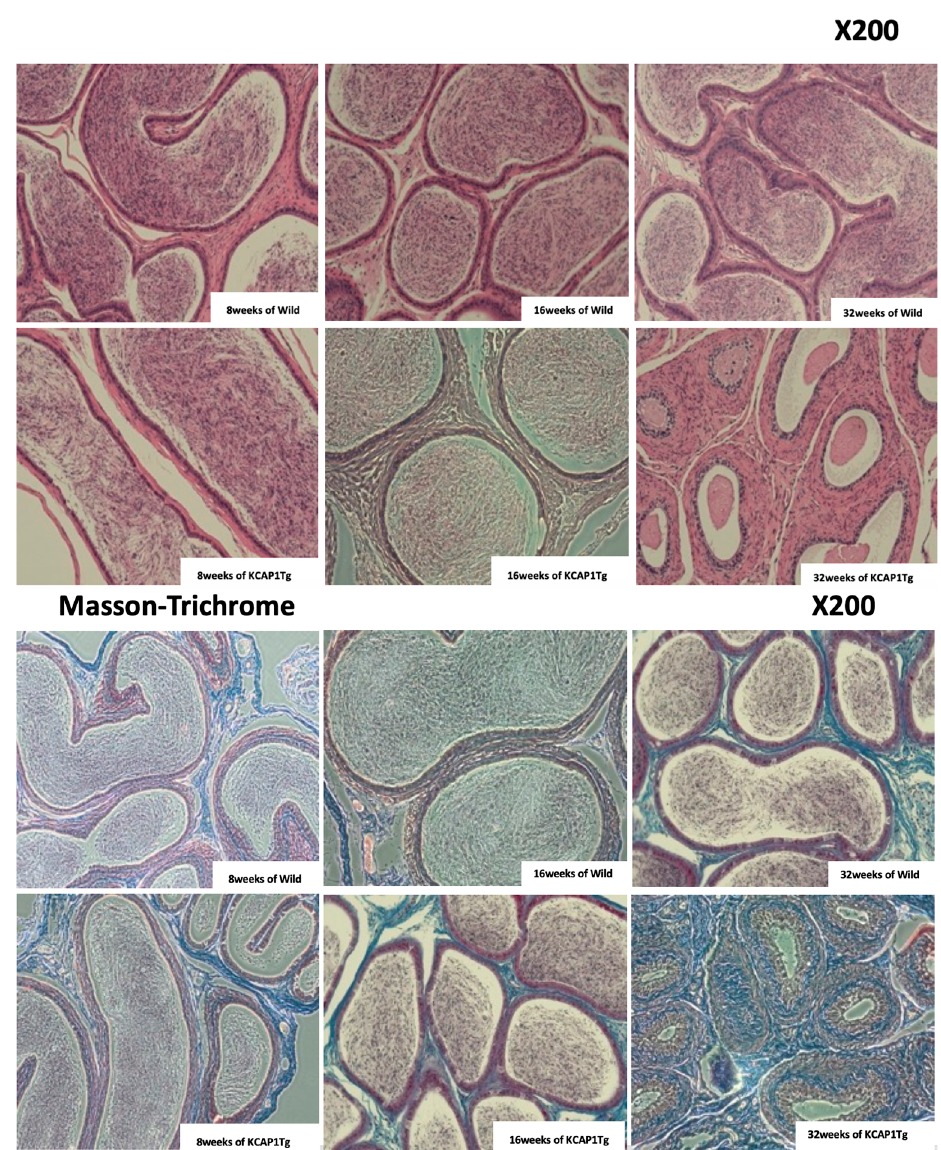
Figure 6. Histological findings for 8, 16, and 32 weeks of age of testis and epididymis in KCASP1Tg and wild-type mice. Histological changes of testis ( A ) and epididymis ( B ) in KCASP1Tg and wild-type mice at 8, 16, and 32 weeks of age were shown ( × 200, × 400). Comparison of the seminiferous tubules cross-sections, KCASP1Tg mice at 32 weeks old showed reduced sperm content in the lumen (L) of seminiferous tubules ( × 200). Large round cells with abnormal mitosis (circled) and sperm head (arrow) were seen in the lumen in KCASP1Tg mice, but not in the wild type. Leydig cells (LC) in KCASP1Tg mice were atrophied compared to wild type ( × 400). The vacuolation of Sertoli cells, syncytia formation, and incorrectly rearranged seminiferous epitheliums were observed in KCASP1Tg mice compared to wild-type littermates of normal tubule cross-sections ( × 400, A ). Di ff erence in the fibrogenesis of seminiferous tubules and interstitial connective tissue was not clear for both groups by Masson trichrome staining of the testis. Hypoxia inducible factor-1 (HIF-1) staining showed no remarkable di ff erence at all ages between the two groups. Immunoglobulin G (IgG) deposition was increased in the stroma surrounding the seminiferous tubules of KCASP1Tg mice, even in mice at 8 weeks of age, but especially at 32 weeks old. Compared to the wild-type mice at 8 weeks of age, the sperm seems not to be mature in KCASP1Tg at 32 weeks of age through caput, corpus, and caudal epididymal regions ( × 40). Fibrogenesis was observed intensely in the ductus epididymidis and connective tissues by Masson trichrome staining ( × 200). S means sperm ( B